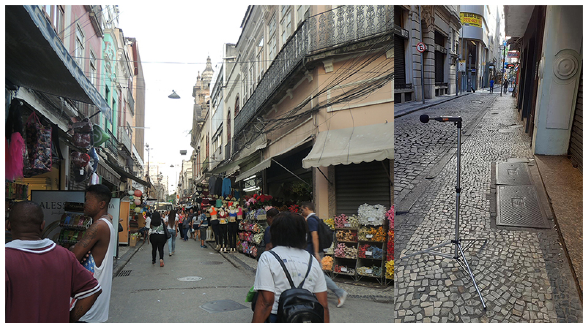
Figure 6: On the left, intense activity on the streets of popular commerce, before the pandemic. on the right, closed shops and deserted streets during the